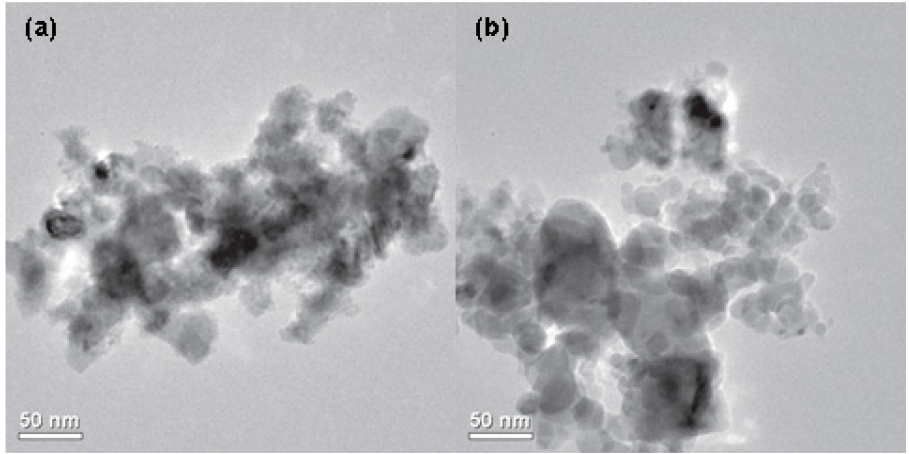
Figure 5. TEM micrograph of ( a ) 1UH and ( b ) 1WH